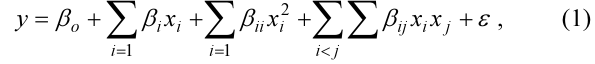
Table 2. Physical properties of fine and coarse aggregates